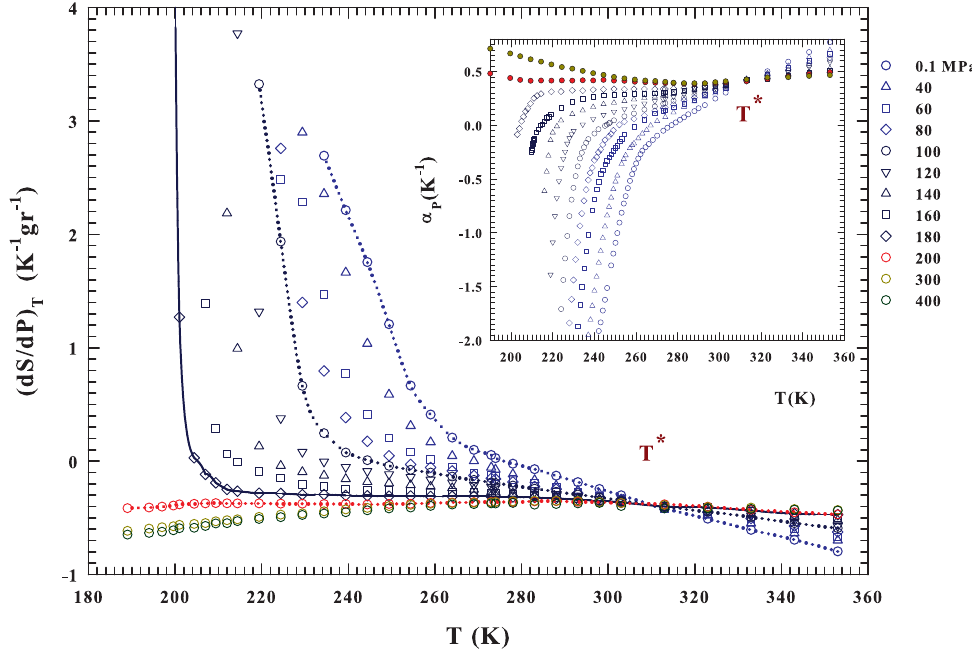
Figure 3. The liquid water isothermal pressure derivative of the entropy ( ∂ S / ∂ P ) T and thet thermal expansion coefficient α P isobars (inset). These functions are calculated from the density data (Figure 2) in the range 180 < T < 360 K for the pressures P = 0.1,40,60,80,100,120,140,160,180,200,300 and 400 MPa. For both the corresponding isobars can be observed that they cross at the same temperature T ∗ = 315 ± 5 K . In both figure and inset it is observed that the data behaviors above and below P = 200 MPa are completely different in curvature and absolute values. Large entropy variations are observable only below such a pressure; while the most significant is found for P = 180